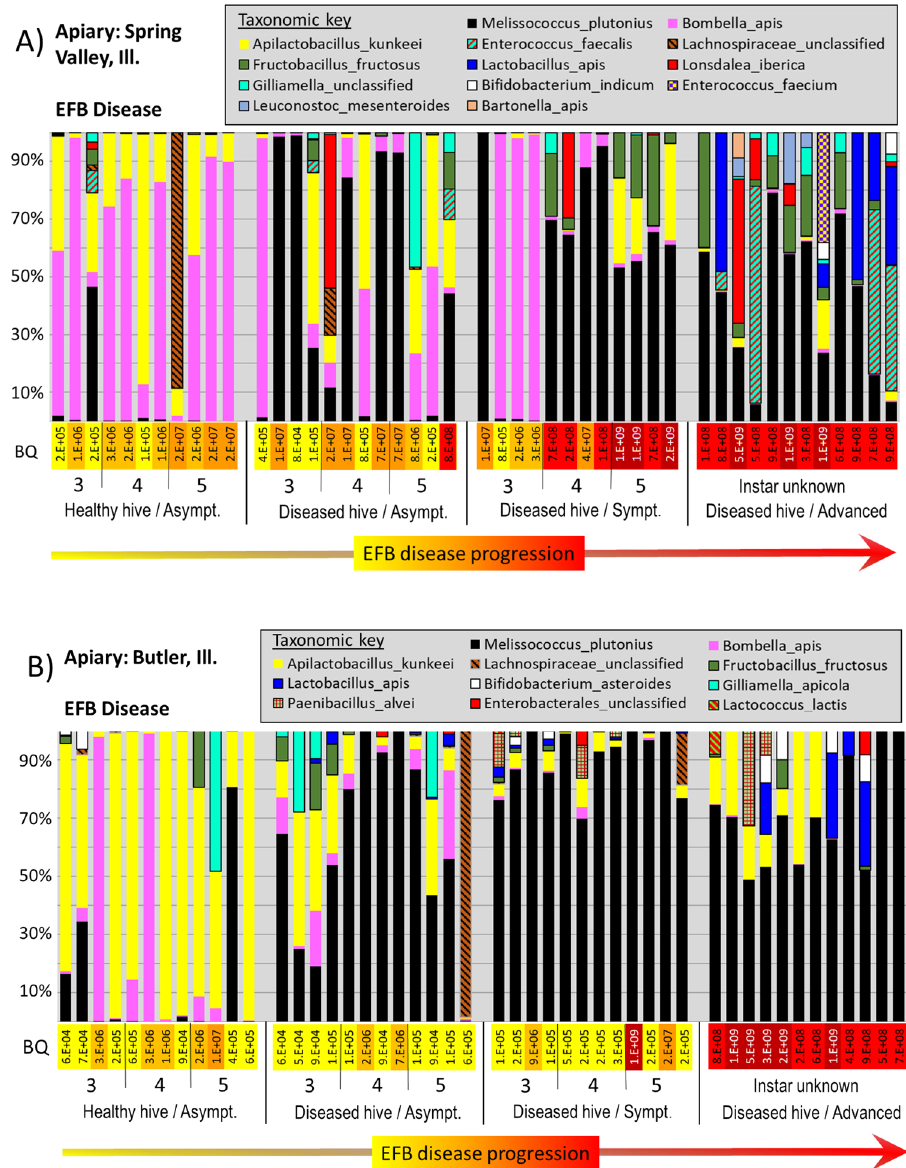
Figure 4. Panels ( A – F ) illustrate disease progression of the larval microbiota from six different apiaries; five with European foulbrood disease ( A – E ) and one with Acute bee paralysis virus-Parasitic mite syndrome (panel F ). Each vertical bar represents a single larval microbiota displayed as relative abundance (y-axis). Larval instar and symptomology are displayed across the x-axis; from left to right are four distinct sample groups selected to capture disease progression: Asymptomatic larvae from an asymptomatic colony, asymptomatic larvae from a symptomatic colony, symptomatic larvae from a symptomatic colony, and advanced disease from a symptomatic colony. BactQuant (BQ) results estimating microbiome size are listed as log notation vertically across each x-axis. On panel ( F ), an RT-qPCR estimate of ABPV viral load is shown at log10 scale below BQ